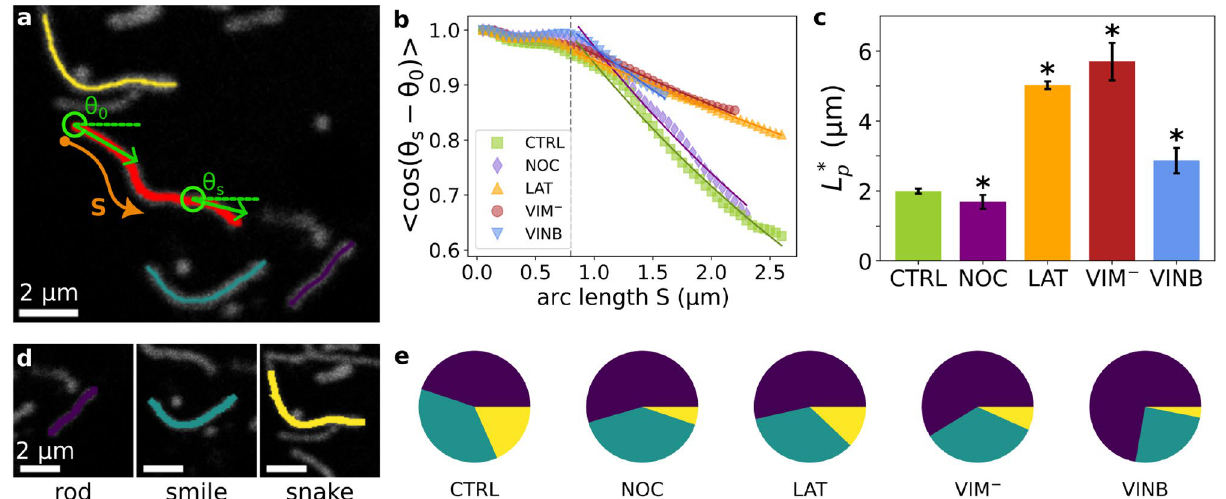
Figure 2. Characterization of mitochondria apparent stiffness and shape distribution. ( a ) Representative confocal image of mitochondria within melanocytes. Elongated mitochondria showing characteristic shapes (shown in colours) were analyzed to compute the tangent angle ( θ , green) at a distance s (orange arrow) from their edge. ( b , c ) Determination of mitochondria apparent persistence length ( L ∗ p ). The ensemble average of the correlation of the tangent angle obtained for each experimental condition was fitted with Eq. (5) to determine the L ∗ p ( b ). L ∗ p values are shown in ( c ) and Supplementary Table S5. The values were considered significantly different with respect to the control condition (indicated by asterisks) if the error intervals did not overlap, as described in “Methods”. ( d , e ) Distribution of mitochondria shapes. Mitochondria shapes were classified as rod- (violet), smile- (light blue) and snake-like (yellow) according to their curvature ( d ). The proportion of these mitochondrial populations obtained for each experimental condition are illustrated in ( e ) and displayed in Supplementary Table